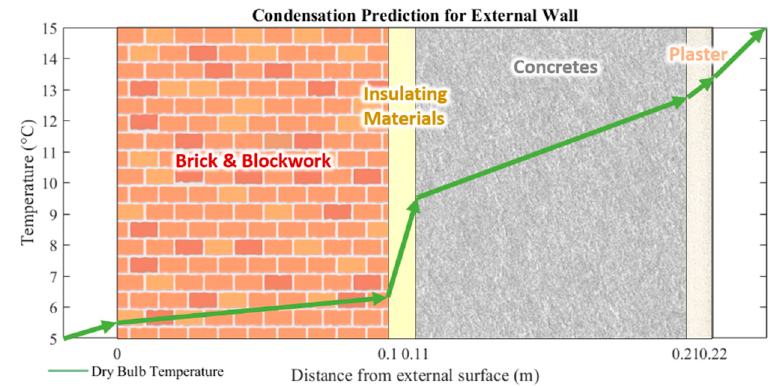
Figure 2. Temperature and condensation prediction for external building wall in IES.